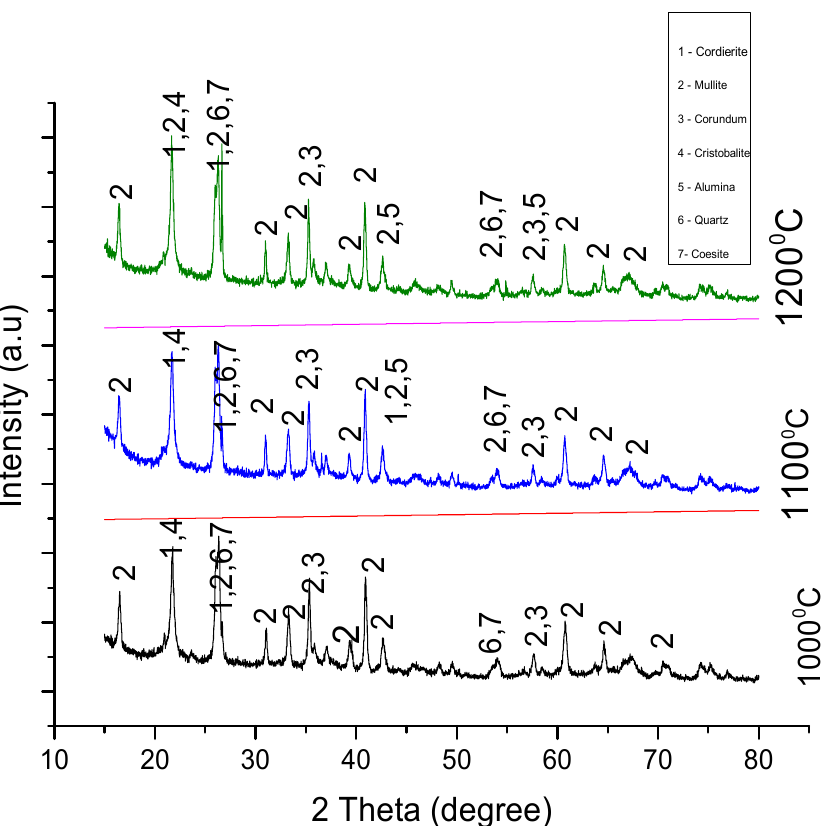
Figure 8. XRD peaks for samples in experiment D sintered at 1000 °C, 1100 °C, and 1200 °C.